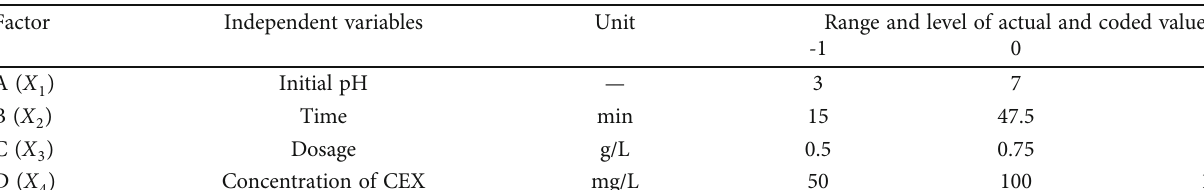
O @SIO particles. 3 4 2